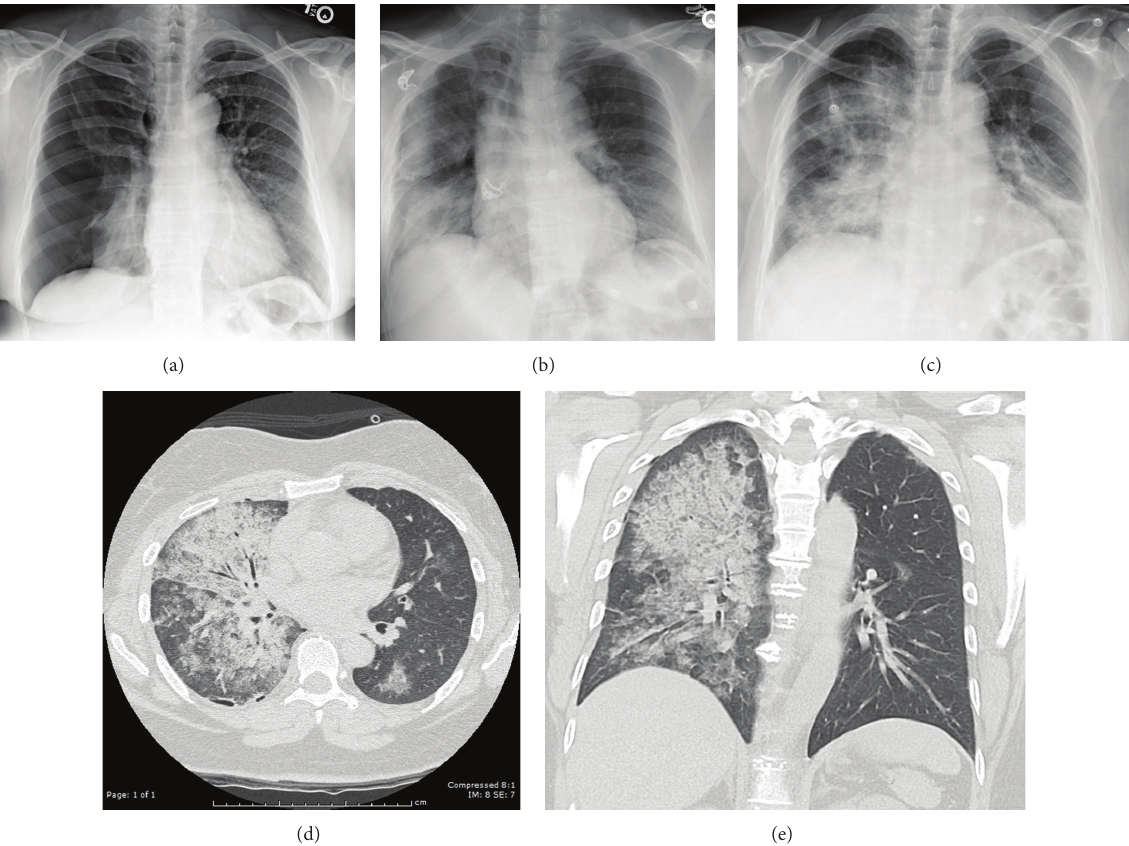
Figure 1: Selected case images. (a) Upright PA/lateral X-ray showing right sided large pneumothorax, (b) portable upright AP X-ray immediate postdecompression, (c) upright PA/lateral showing interval progression of REPE on day 2, (d) representative axial section (expiratory view, high resolution CT), and (e) representative coronal CT